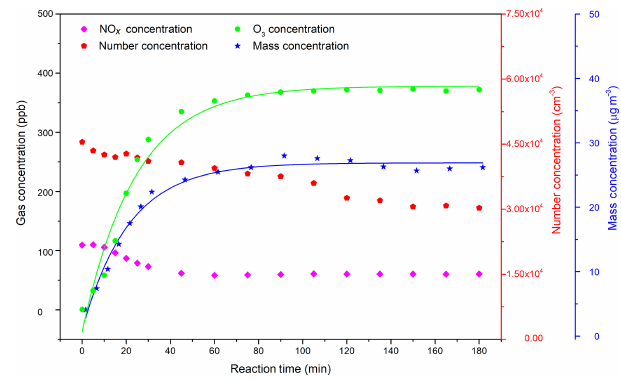
Figure 2. Profile of the gas-phase concentrations of reactants (NO, NO 2 , NO x , and O 3 ) and particle number / mass concentrations (corrected with wall loss) over time. The C 4 H 4 O / NO x ratio is 7.9 and RH = 23%. Since the particle wall loss has a weak RH depen- dence in our chamber, a mean value of 4 . 7 × 10 − 5 s − 1 was used for wall loss correction. A density of 1.4gcm − 3 was used in the SMPS (Jia and Xu, 2018; Kostenidou et al.,